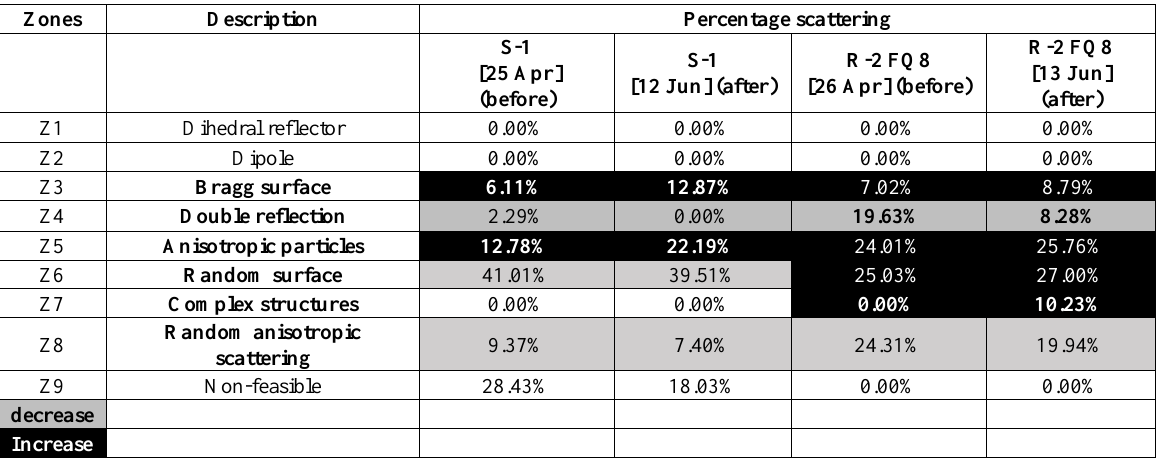
Table 2. Percentage scattering in each zone from before and after lodging image pairs derived using near date Sentinel-1 and low incidence angle RADARSAT-2 FQ8 data. Main scattering mechanism changes are highlighted in the table. The main one is in